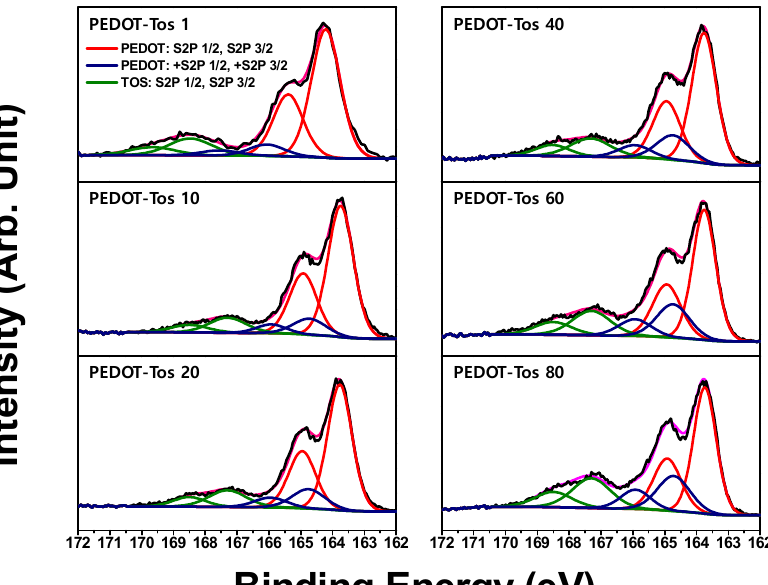
Figure 5. X-ray photoelectron spectroscopy (XPS) analysis confirms the ratio of sulfonate anions (Tos) and thiophene (EDOT) tend to increase with the concentrations of the oxidant. The doublet with a binding energy of about from 166 to 170 eV represents Tos, whereas the thiopehen of the PEDOT chain has a binding energy of about 162.5 to 166.5 eV. The PEDOT-Tos 1 exhibits peak shifts toward higher energy, which is considered to be a weak interaction with the counter-ion.